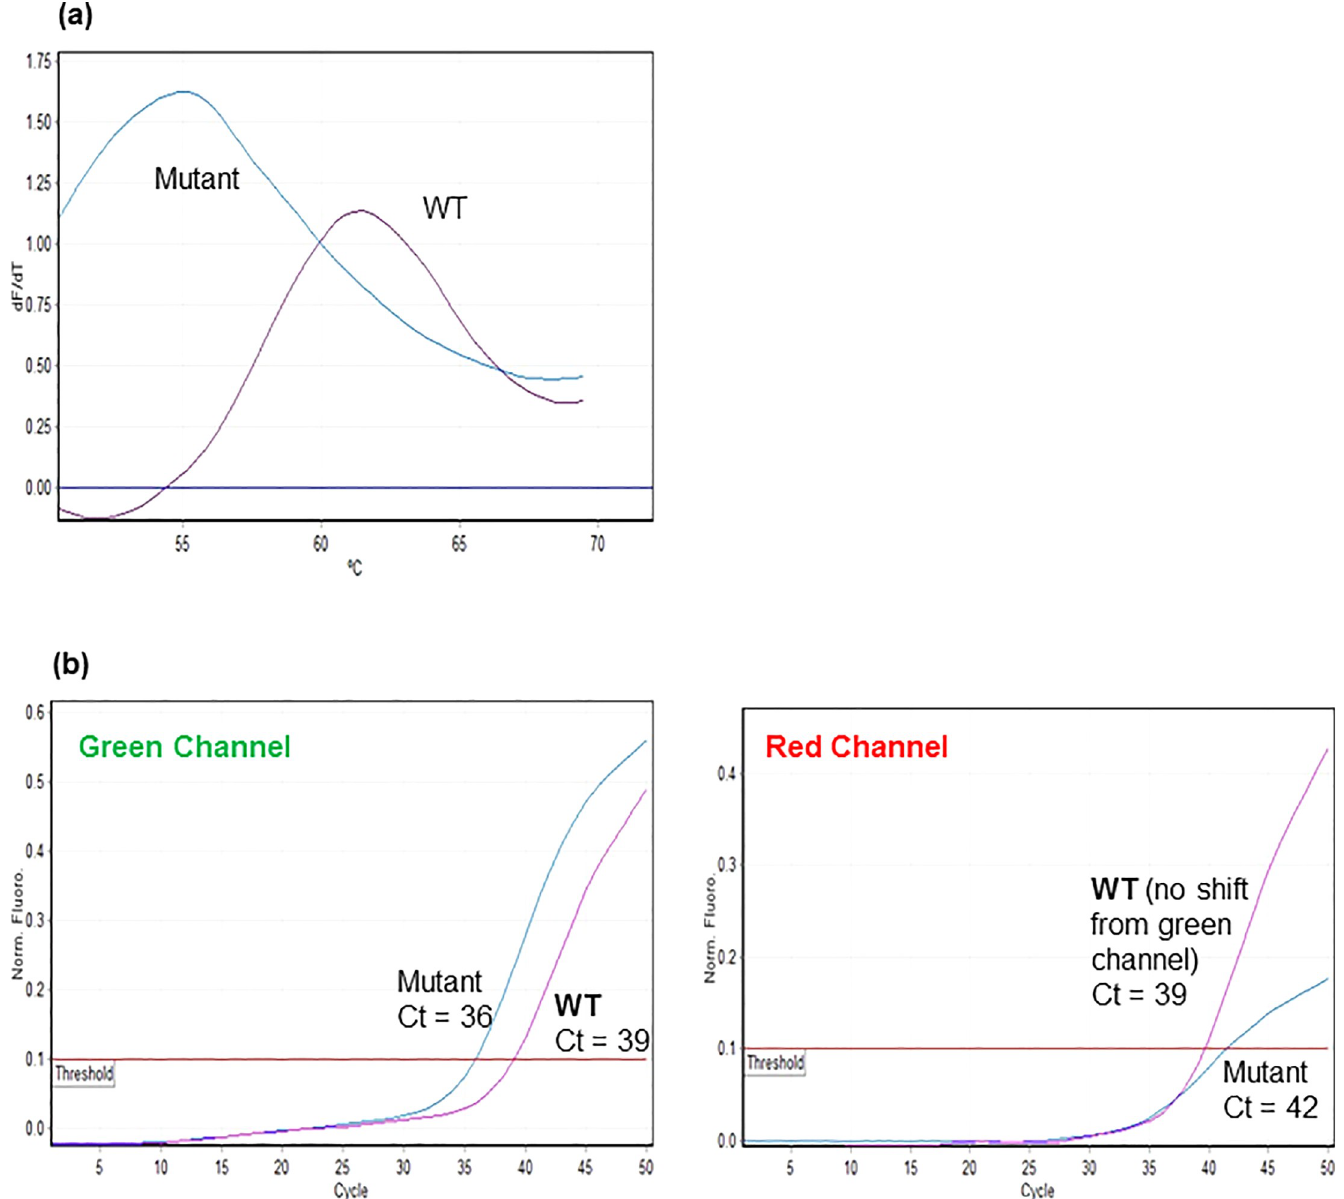
Fig 1. Melt curve analysis and observed changes in Ct values. (a) Analyzed melt curves for 2 specimens; 1 wild-type (purple curve) and 1 mutant (blue curve); (b) shift in Ct values for 2 samples, wild type (purple curve) and mutant (blue curve), red channel Ct minus green channel Ct.